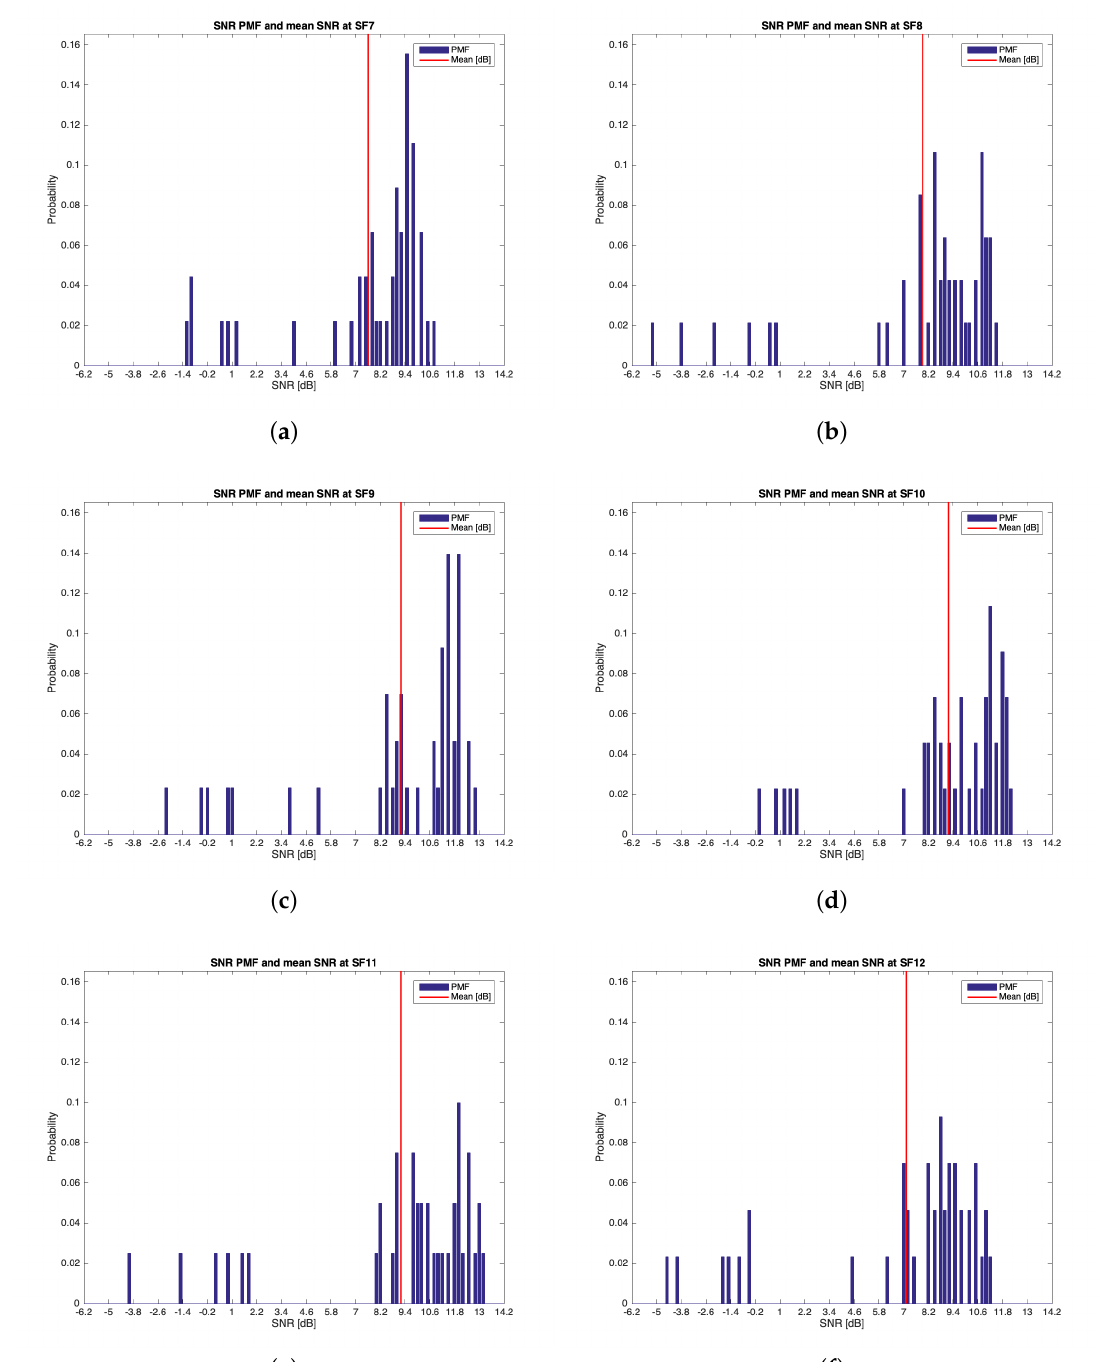
Figure 12. Group #1 SNRs PMFs: ( a ) SF = 7; ( b ) SF = 8; ( c ) SF = 9; ( d ) SF = 10; ( e ) SF = 11; ( f ) SF =